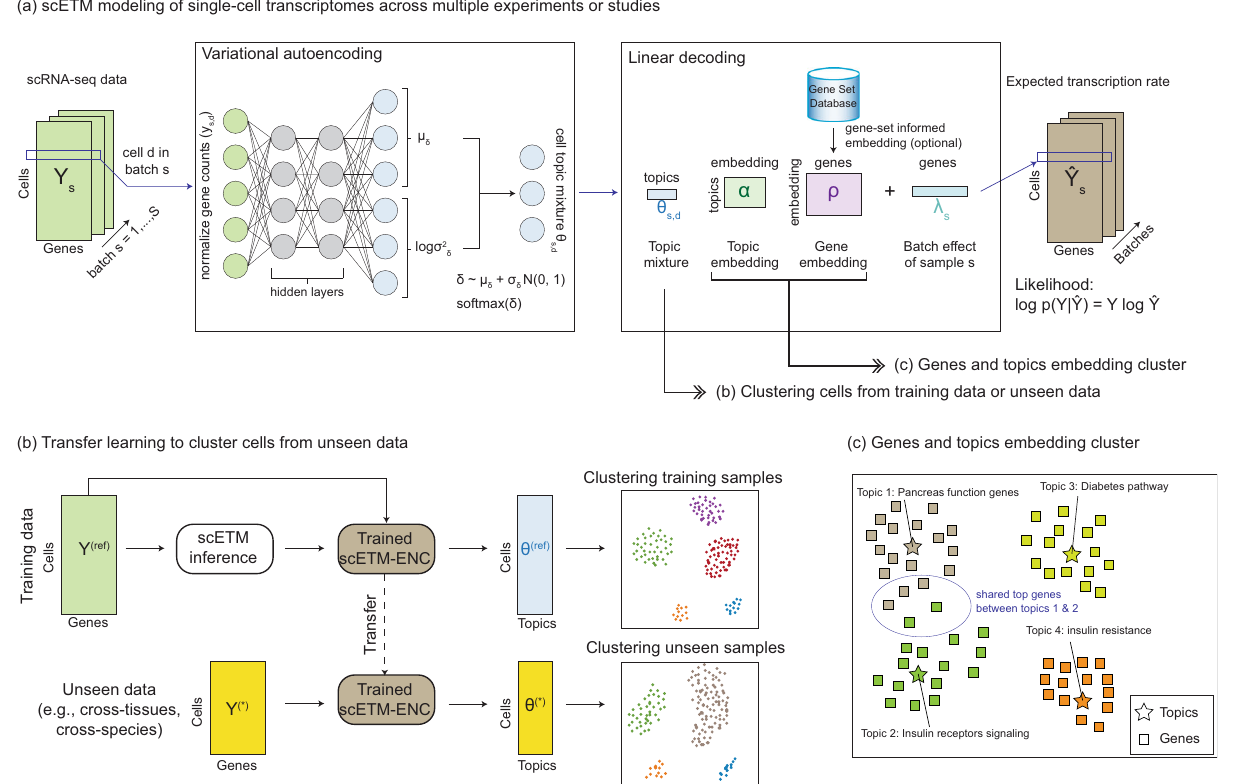
Fig. 1 scETM model overview. a scETM training. Given as input the scRNA-seq data matrices across multiple experiments or studies (i.e., batches), scETM models the single-cell transcriptomes using an embedded topic-modeling approach. Each scRNA-seq pro fi le serves as an input to a variational autoencoder (VAE) as the normalized gene counts. The encoder network produces a stochastic sample of the latent topic mixture ( θ s , d for batch s = 1, … , S and cell d = 1, … , N s ), which can be used for clustering cells (see panel b ). The linear decoder learns topic embedding and gene embedding, which can be used to analyze cellular programs via enrichment analyses (see panel c ). b Work fl ow used to perform zero-shot transfer learning. The trained scETM-encoder on a reference scRNA-seq dataset is used to infer the cell topic mixture θ * from an unseen scRNA-seq dataset without training them. The resulting cell mixtures are then visualized via UMAP visualization and evaluated by standard unsupervised clustering metrics using the ground-truth cell types. c Exploring gene embeddings and topic embeddings. As the genes and topics share the same embedding space, we can explore their connections via UMAP visualization or annotate each topic via enrichment analyses using known